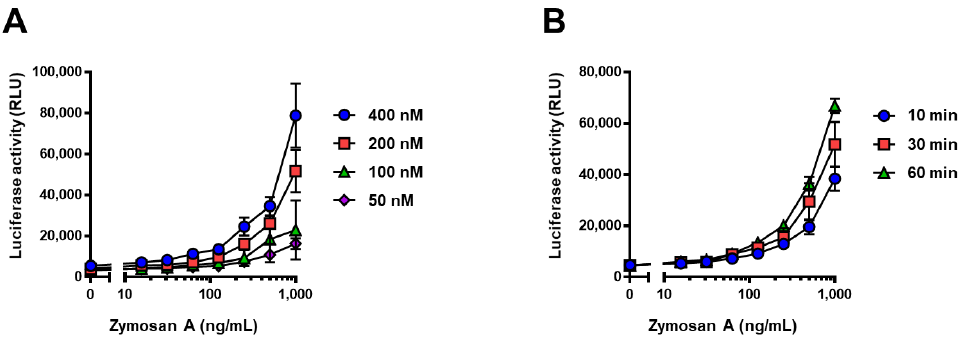
Figure 3. Effect of different concentrations and incubation time periods on split-NanoLuc comple- mentation assay. ( A ) Different concentrations of mixture of supBGRP-LgBiT and Neg1-E321Q-SmBiT (5 µ L) were incubated with 10 µ L of zymosan A (0–1000 ng/mL) for 30 min. ( B ) Zymosan A (0–1000 ng/mL, 10 µ L) was incubated with the mixture solution of supBGRP-LgBiT and Neg1-E321Q- SmBiT (200 nM each, 5 µ L) for different time points (10, 30, and 60 min). After incubation, 15 µ L of furimazine solution were added and NanoLuc activity was measured. Data are presented as the mean ± SD of values in four